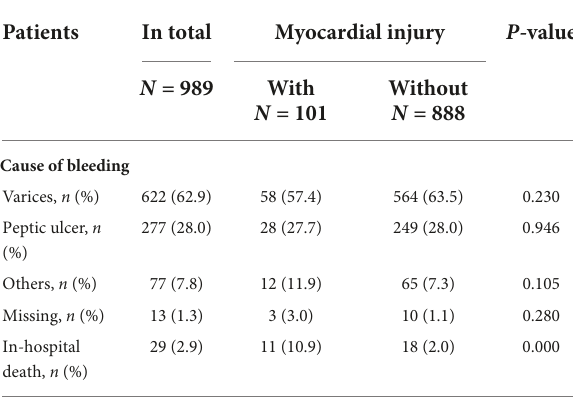
TABLE 1 Clinical characteristics of AUGIB patients with and without myocardial